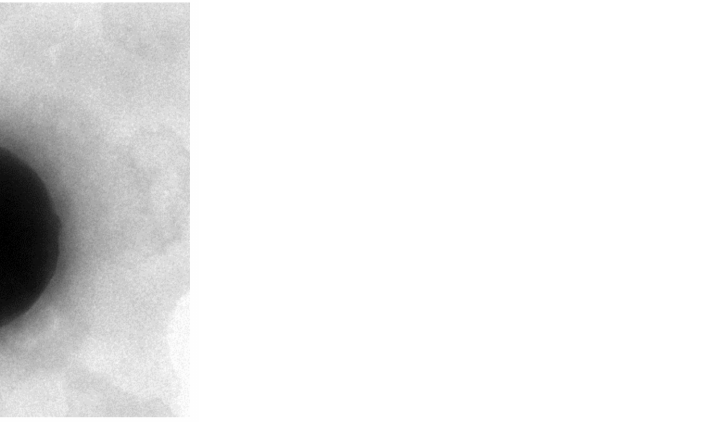
Figure 2. TEM image of MGN–NLC. The scale bar represents 50 nm. The sample size in the picture is 187.3